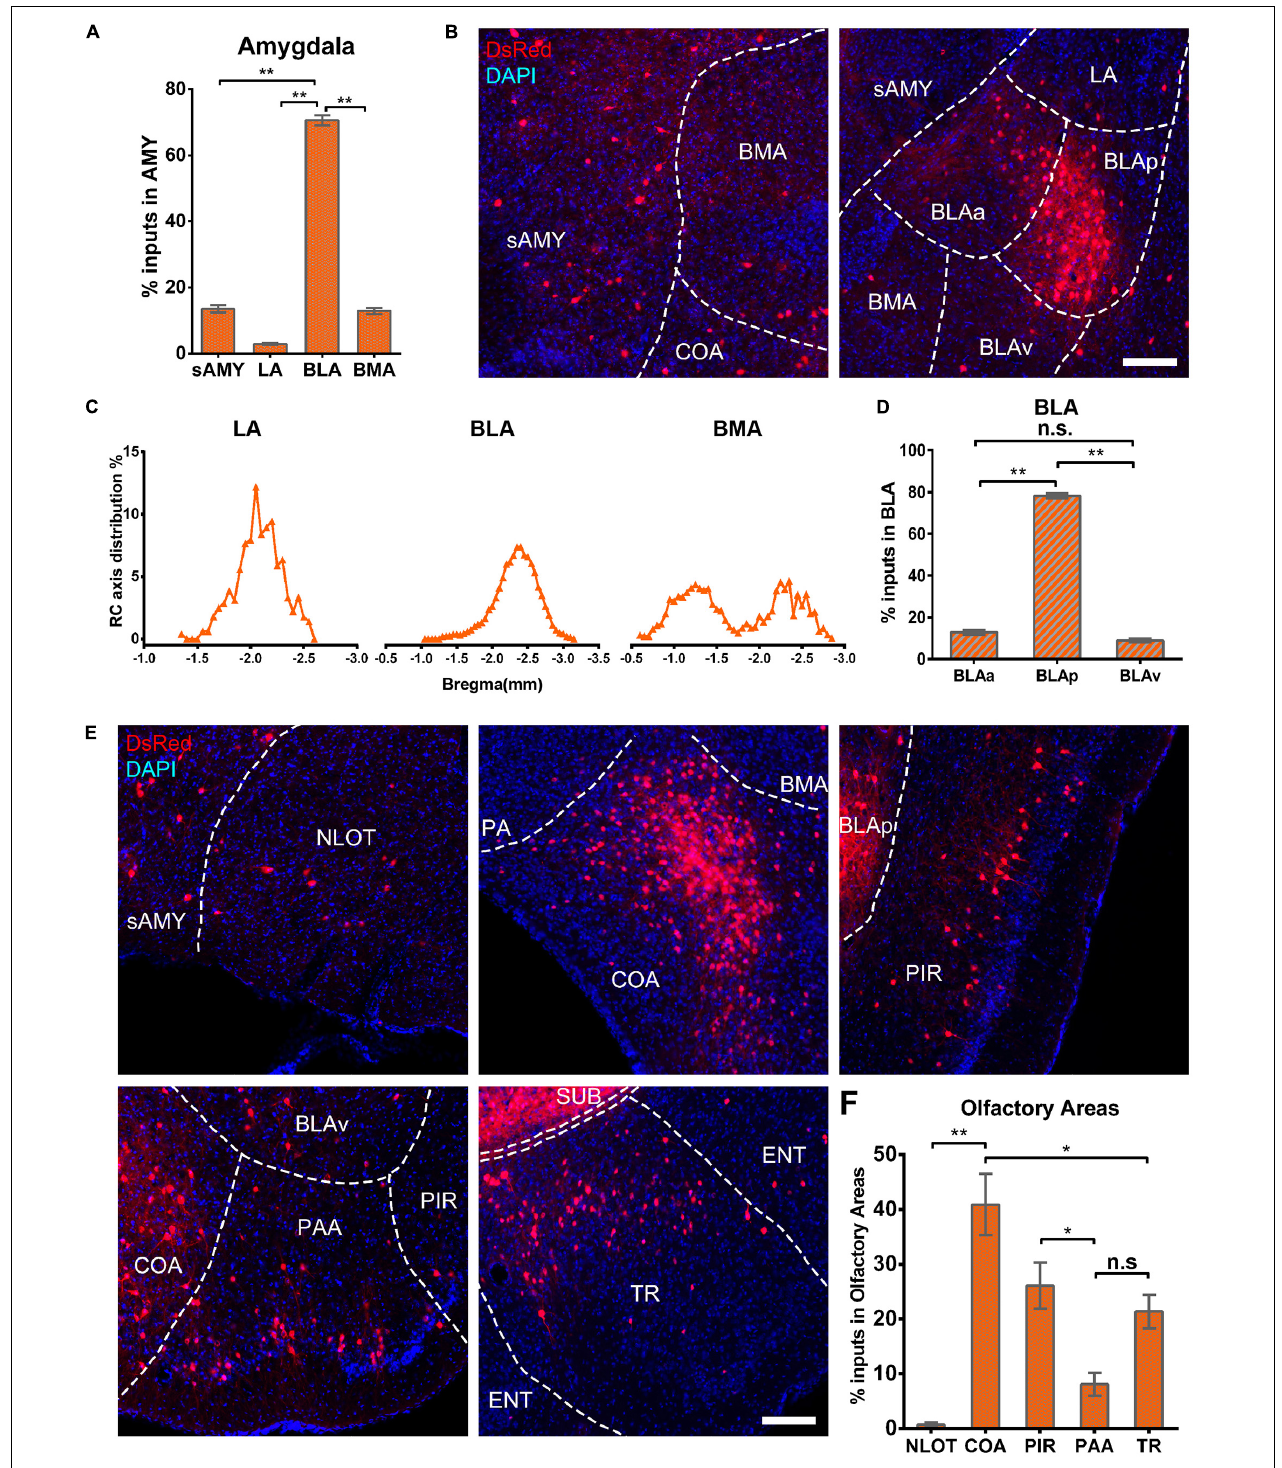
FIGURE 9 | Amygdala nuclei and OLF inputs to ventral CA1. (A) Distribution of the input neurons within the subregions of amygdala nuclei. (B) Representative images showing inputs from the subregions of amygdala nuclei to the projection cells of ventral CA1. Scale bar: 250 µ m. (C) Distribution patterns of the input neurons along the RC axis in LA, BMA, and BLA. (D) Distribution of the input neurons within the subregions of BLA. The BLA was mainly divided into the BLAa, BLAp, and BLAv. (E) Representative images showing presynaptic neurons in the subregions of OLF to the projection cells of ventral CA1. Scale bar: 250 µ m. (F) Distribution of the input neurons within subregions of the OLF. n.s., no significant difference; * P < 0.05; ** P < 0.01.